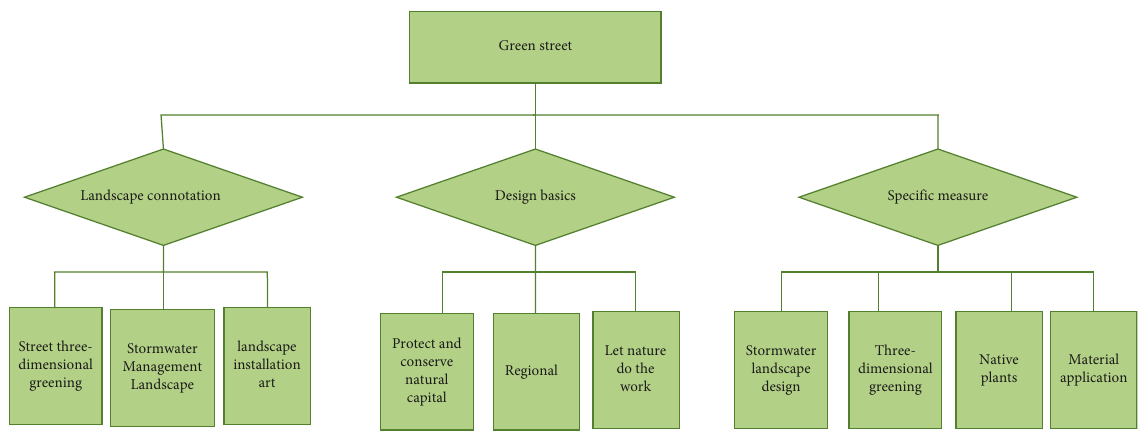
Figure 2: Landscape connotation, design principles, and specific measures of green streets.